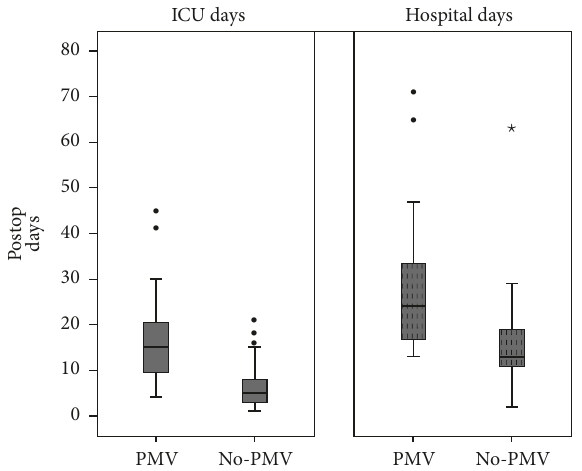
Figure 2: Box plot showing the distribution of postoperative ICU and hospital length of stay stratified according to duration of postoperative ventilation status. Patients in the PMV group had significantly longer ICU and hospital LOS compared with the non- PMV group. ICU: intensive care unit; LOS: length of stay; PMV: prolonged mechanical ventilation. Circles and stars refer to outliers or extreme